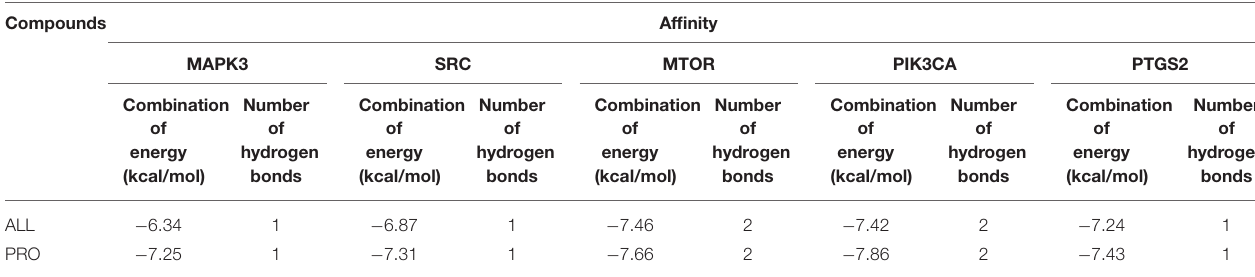
TABLE 5 | Binding energy of the active ingredients in MPTA to the core